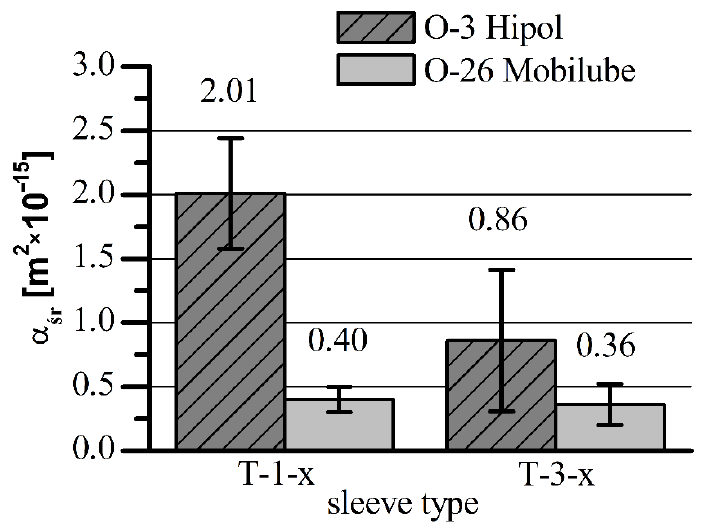
Figure 6. Comparison of the average stabilized values of permeability of the tested sleeves for the two oils: Hipol 15F (O-3) and Mobilube 1SHC (O-26).